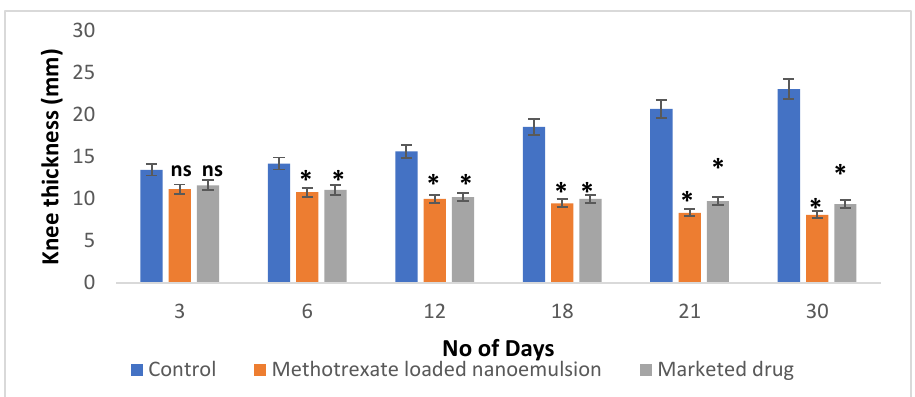
Figure 11. Knee-edema studies in complete-Freund-adjuvant-induced arthritis model. Results are shown as mean ± SEM ( n = 6) and analyzed by one-way ANOVA followed by Tukey’s test; ns: non-significant; * p < 0.05 significance difference to compared to control group.